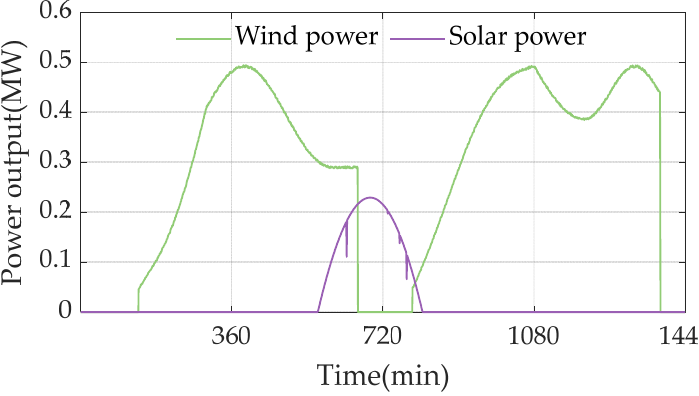
Figure 14. Renewable power output for hydrogen production in Scenario II. The concentration changes of Pipe 1 and Pipe 2 are the same as in Section 5.4.1.